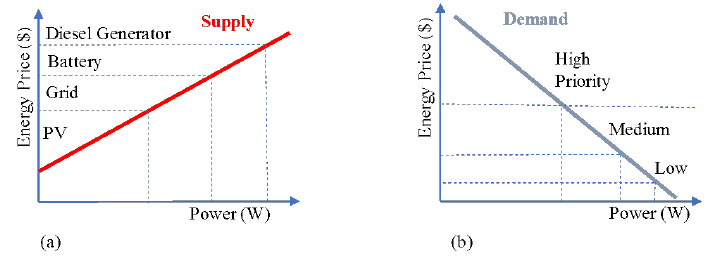
Figure 1. ( a ) Price versus Supply. ( b ) Price versus Demand.